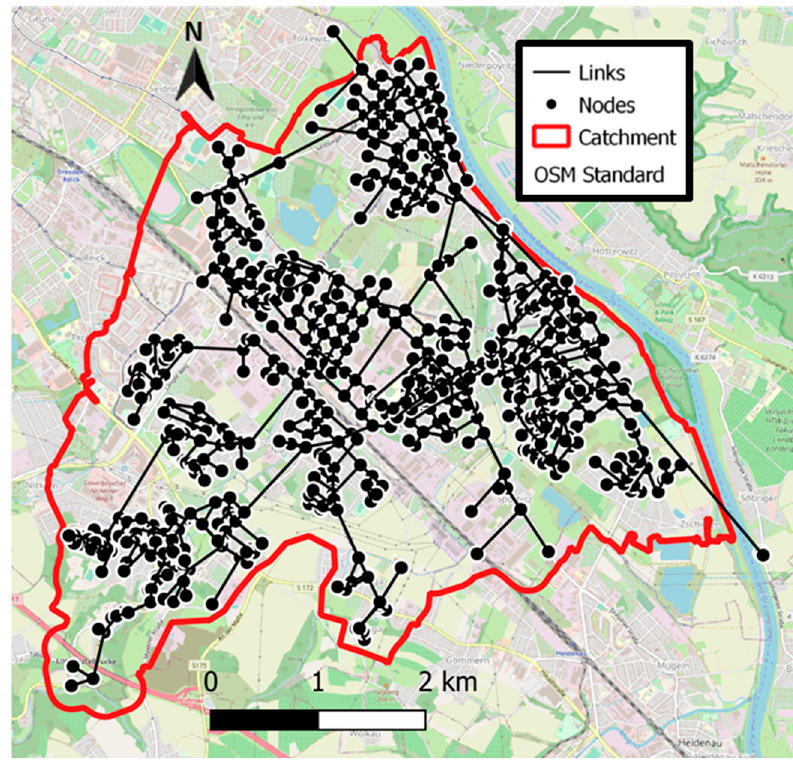
Figure 1. Urban drainage network (UDN) and catchment in the study area.